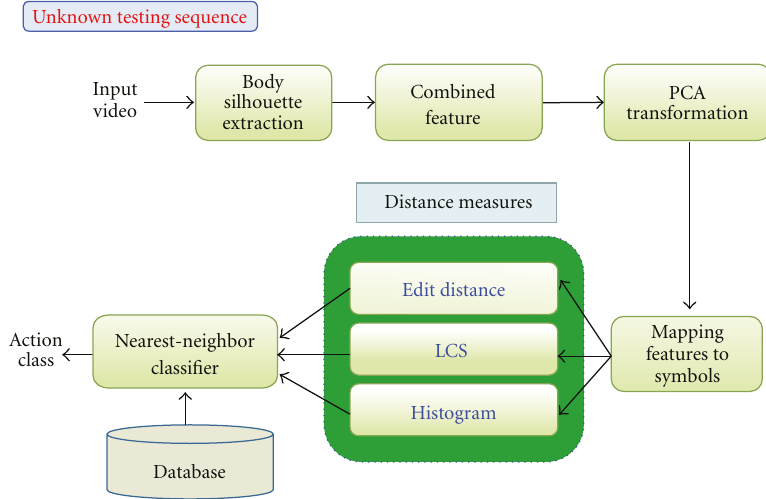
Figure 7: The flowchart for the 3 compared distance measures.